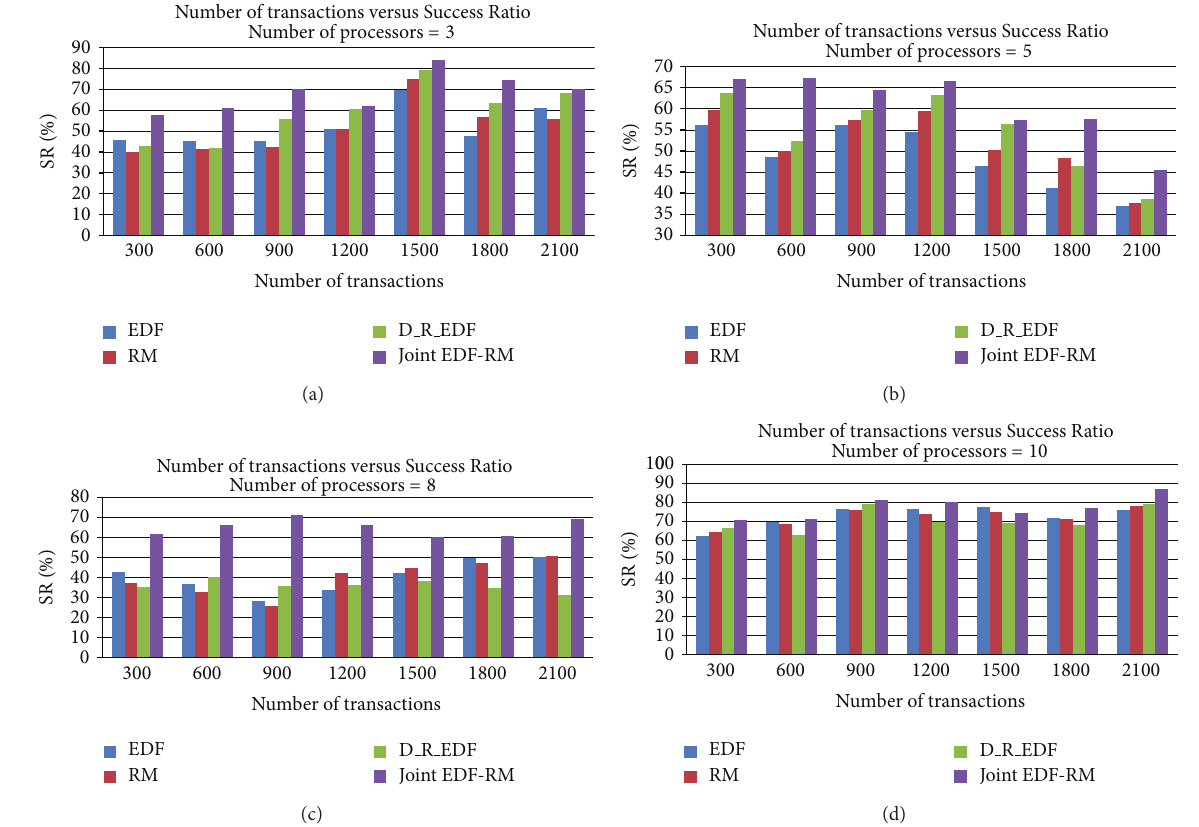
Figure 11: Number of transactions versus Success Ratio on 3, 5, 8, and 10